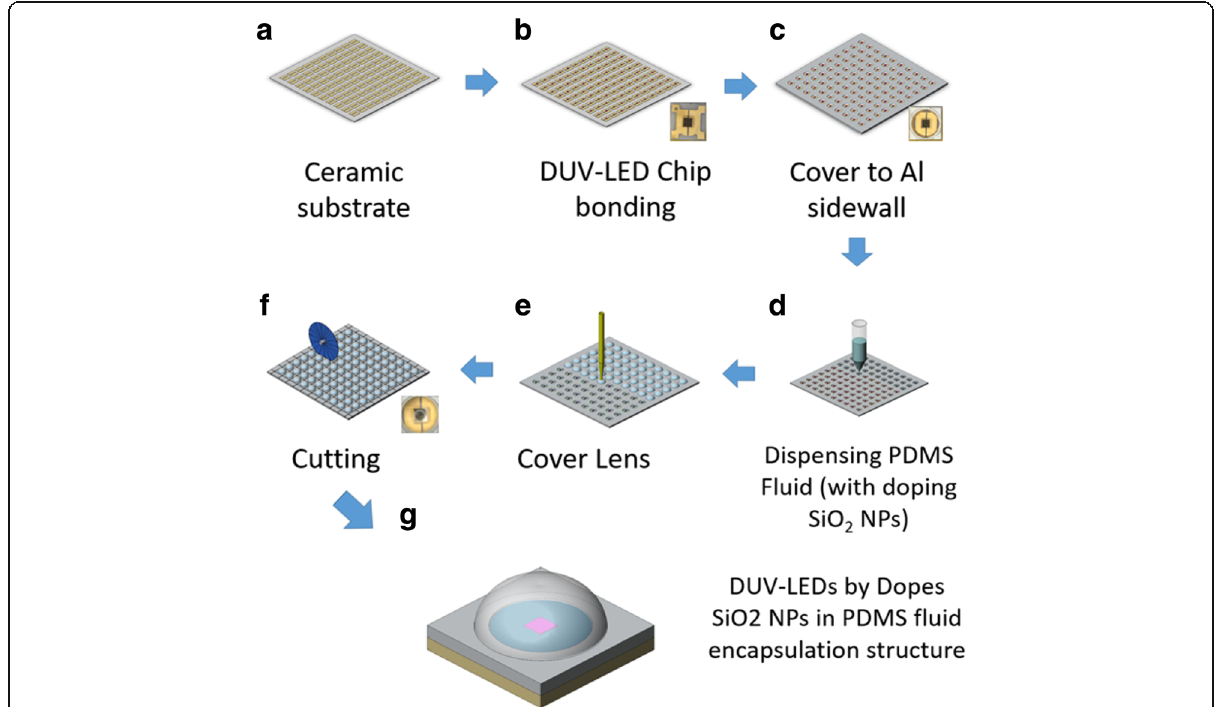
Fig. 1 Fabrication of DUV-LED encapsulation structure: a ceramic substrate, b DUV-LED chip (peak wavelength, 275nm) bonded to a ceramic substrate through pressure bonding, c aluminum plate bonded to the DUV-LED ceramic substrate, d doped binder dispensed into the cavity, e a quartz lens cover placed on the structure, f cut-out finished DUV-LEDs, and g complete DUV-LED with a SiO 2 -NP-doped PDMS fluid encapsulation